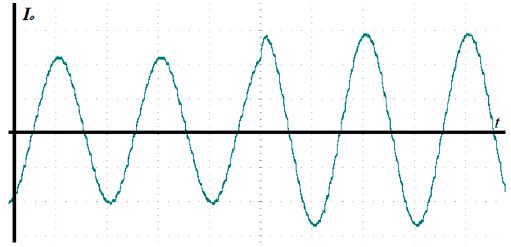
Figure 15. Dynamic response when the amplitude of output reference current changes suddenly, I o (1 A/div).